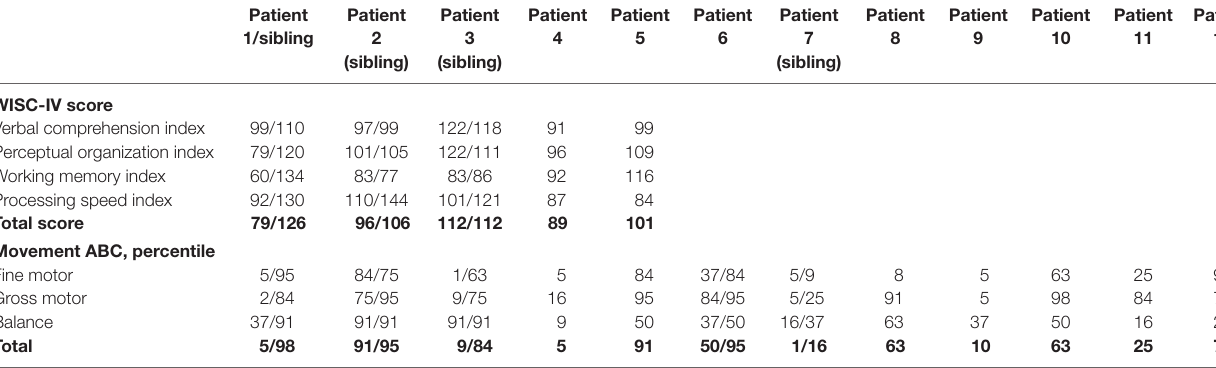
TaBle 5 | Cognitive score and motor function for children with congenital hyperinsulinism above 6 years of age and healthy siblings as controls.